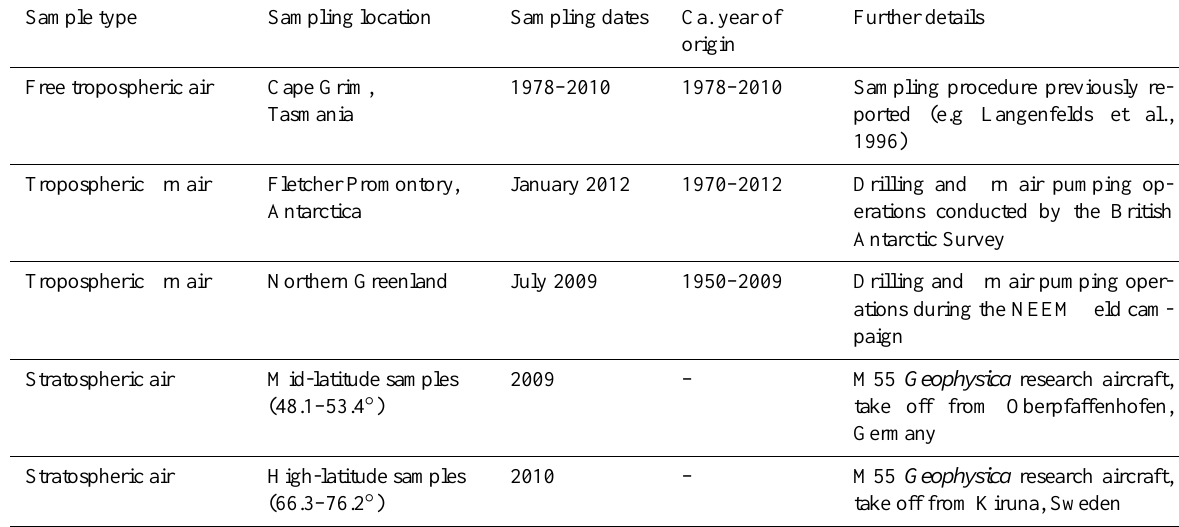
Table 2. Details of the samples used in this